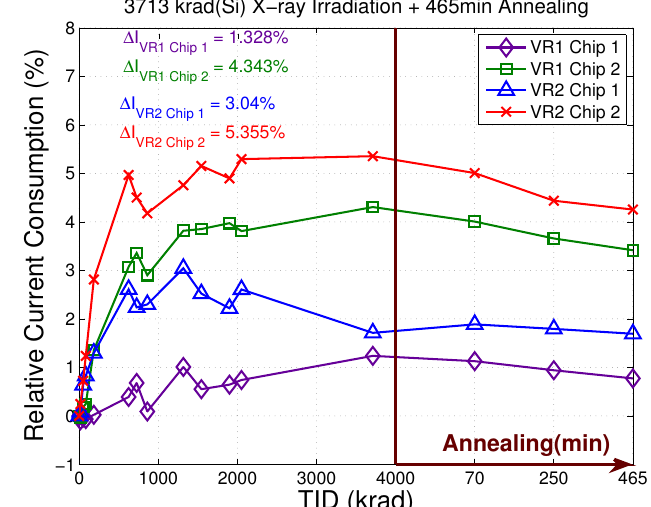
Figure 17. Relative current consumption (%) of the VR1 and VR2 when exposed to X-rays at a dose rate of 8.75